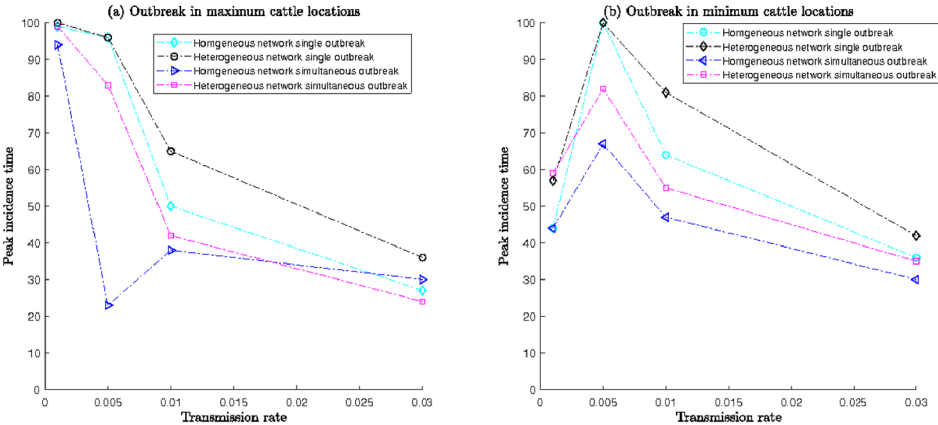
Fig 12. Peak infection time with transmission rate and for outbreaks starting in location/locations with (a) greater number of cows and (b) fewer number of cows.